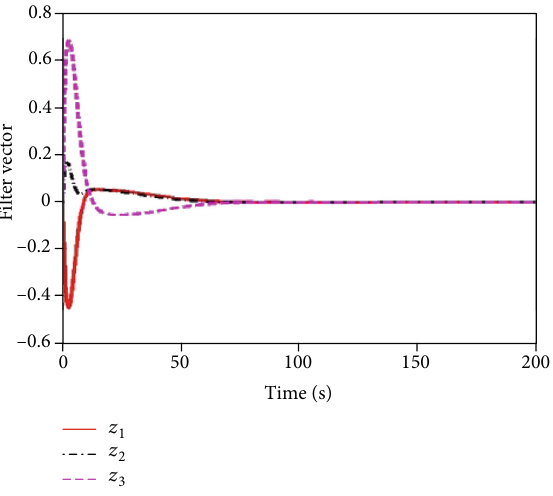
Figure 6: Time histories of fi lter vector in Case